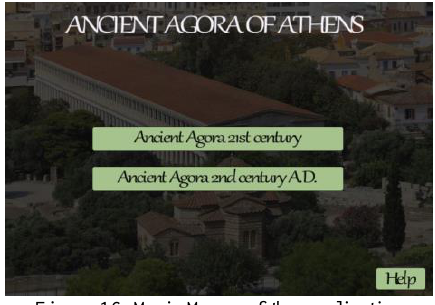
Figure 16: Main Menu of the